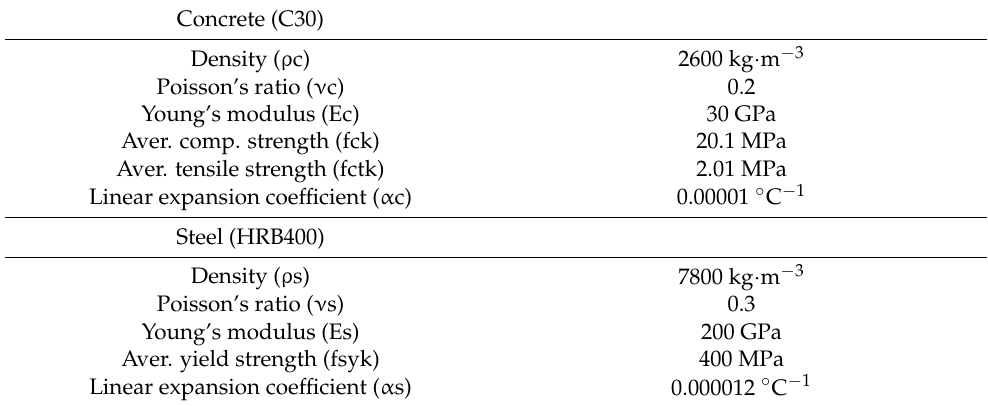
Figure 2. The geometric cross-section size and reinforcement details (unit: mm). Table 1. Material properties.